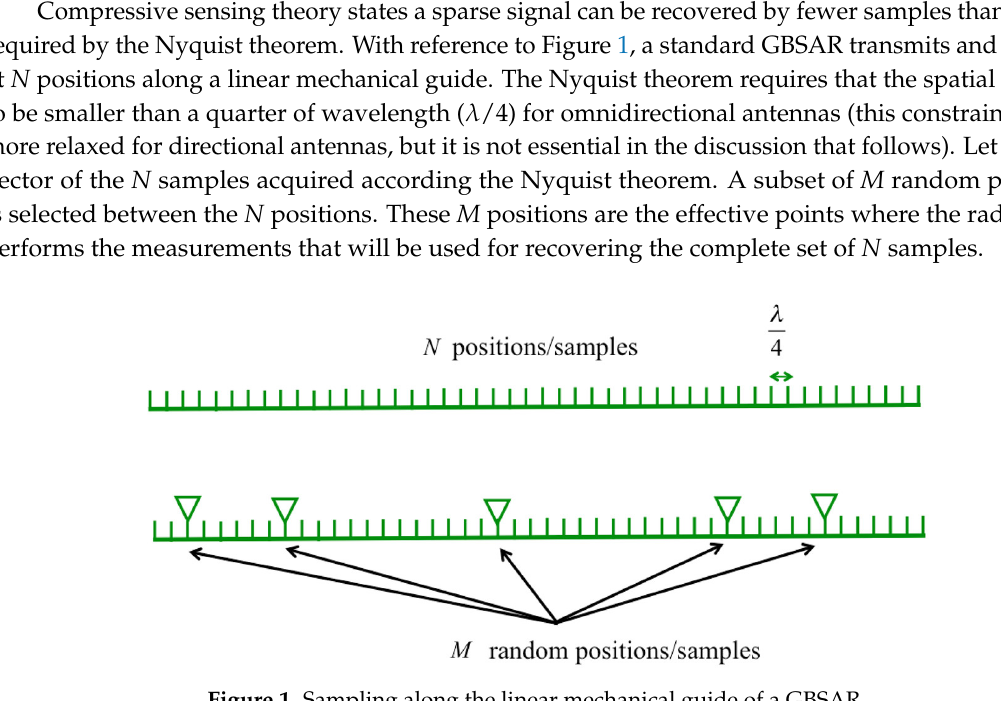
Figure 1. Sampling along the linear mechanical guide of a GBSAR.